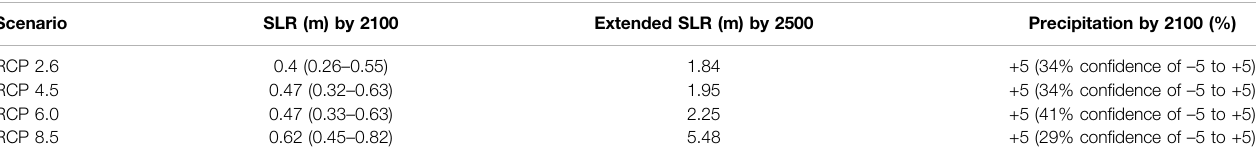
TABLE 1| Tableshowingsea levelriseby2100(m),sea level rise(SLR)by2500asprojectedbytheextended concentrationpathways, and ratesofincreaseinprecipitation by